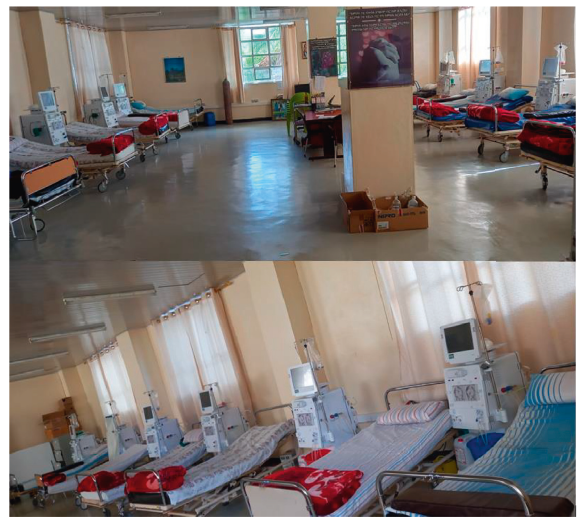
Figure 4: A picture of Ayder Hospital’s haemodialysis centre displaying empty beds and having no patients connected to the haemodialysis machine due to lack of haemodialysis